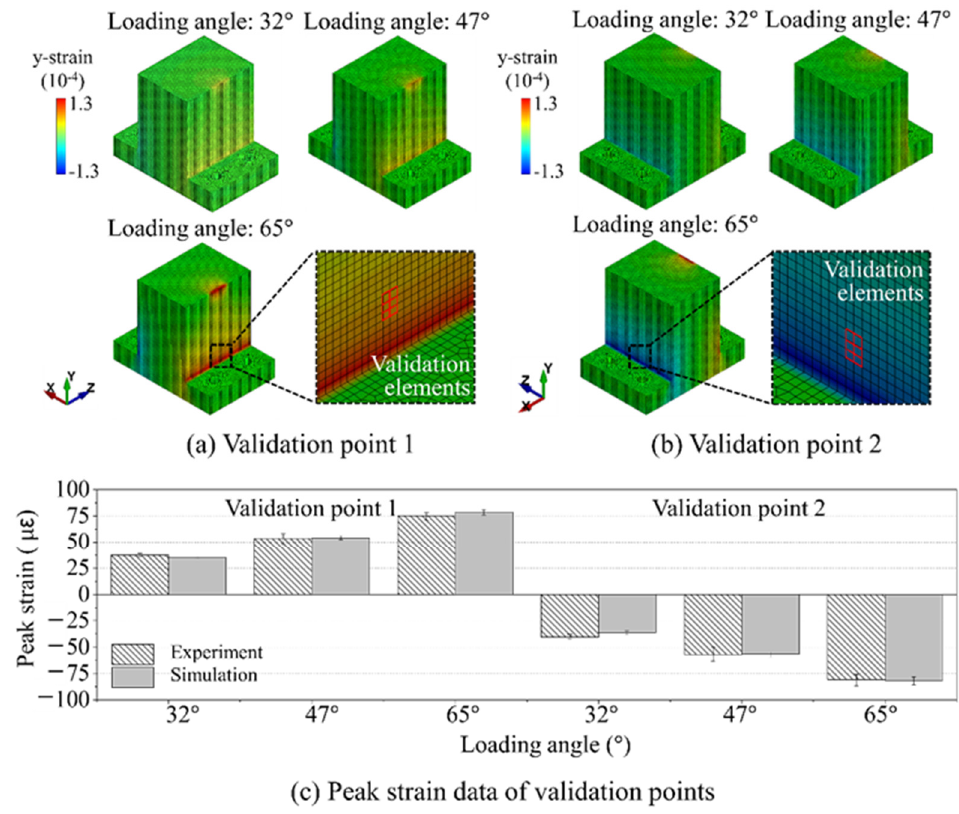
Figure 5. Validation of reconstructed impact load. ( a ) Contour representations of y-axis strain distribution with validation elements of Validation point 1; ( b ) contour representations of y-axis strain distribution with validation elements of Validation point 2; ( c ) comparison of experimentally measured and numerically calculated peak strain values. Table 2. Peak strain data measured at validation points in the lab-scale impact